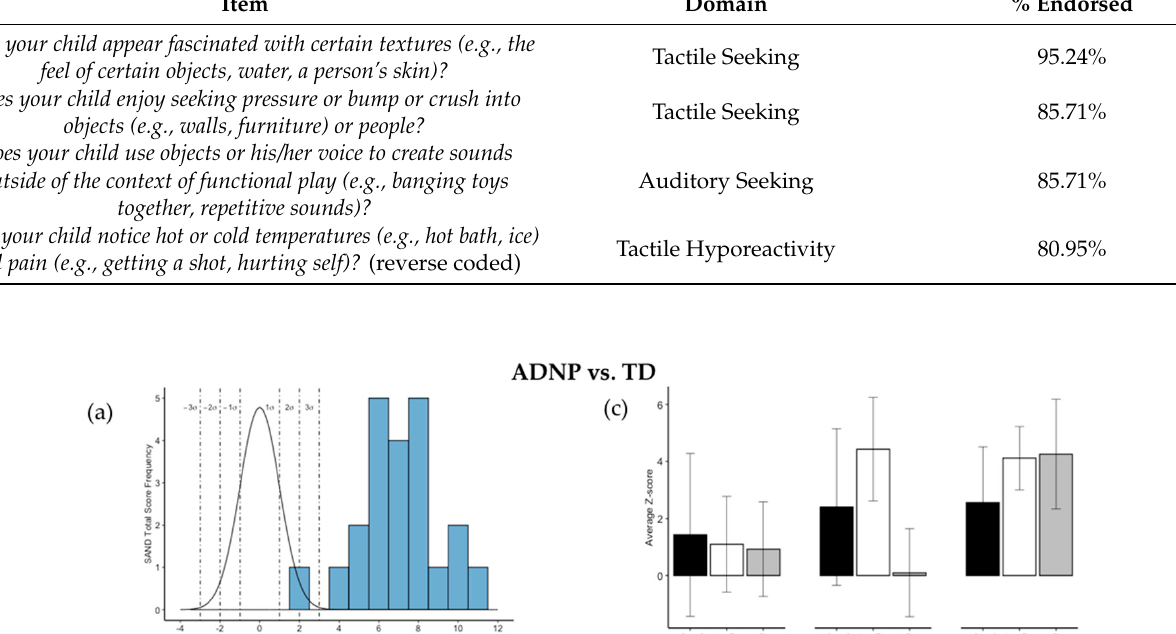
Table 1. Most commonly endorsed items on the Sensory Assessment for Neurodevelopmental Disorders (SAND) Interview. Item Domain % Endorsed